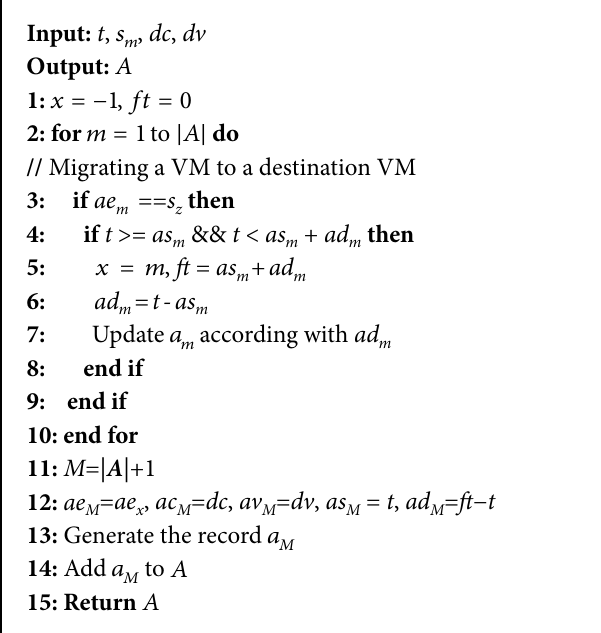
Algorithm 1 specifies the key idea for edge server